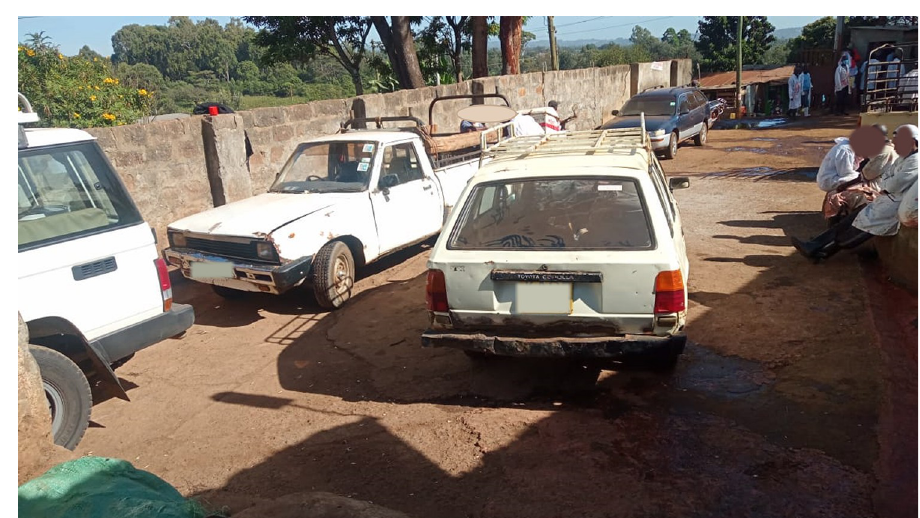
Fig 2. An image showing a sedan vehicle for pig transportation.